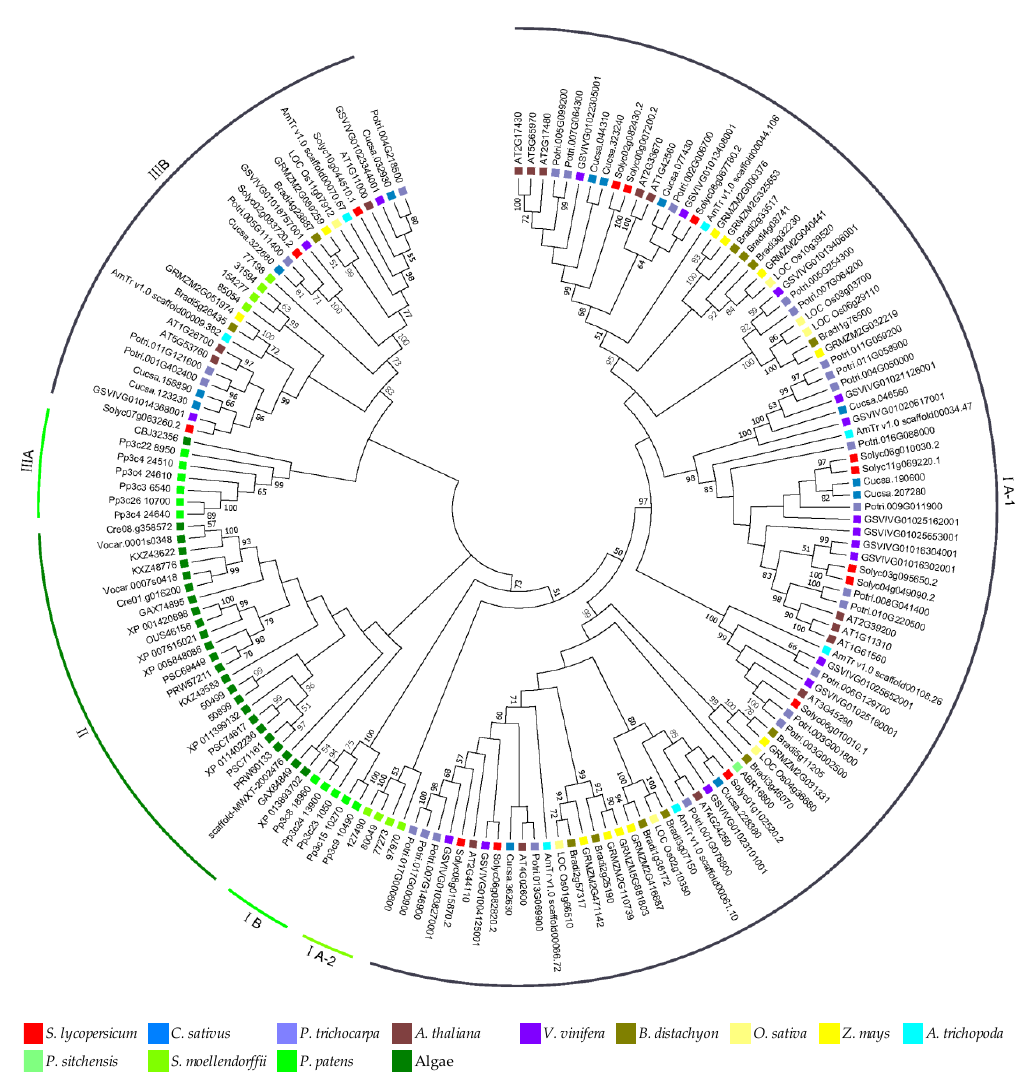
Figure 2. The phylogenetic tree of MLO genes in 28 plant species. The phylogenetic tree was constructed using the amino acid sequences of MLO conserved domains via maximum likelihood (ML) method. The selected 164 MLO genes were distributed on six clades.